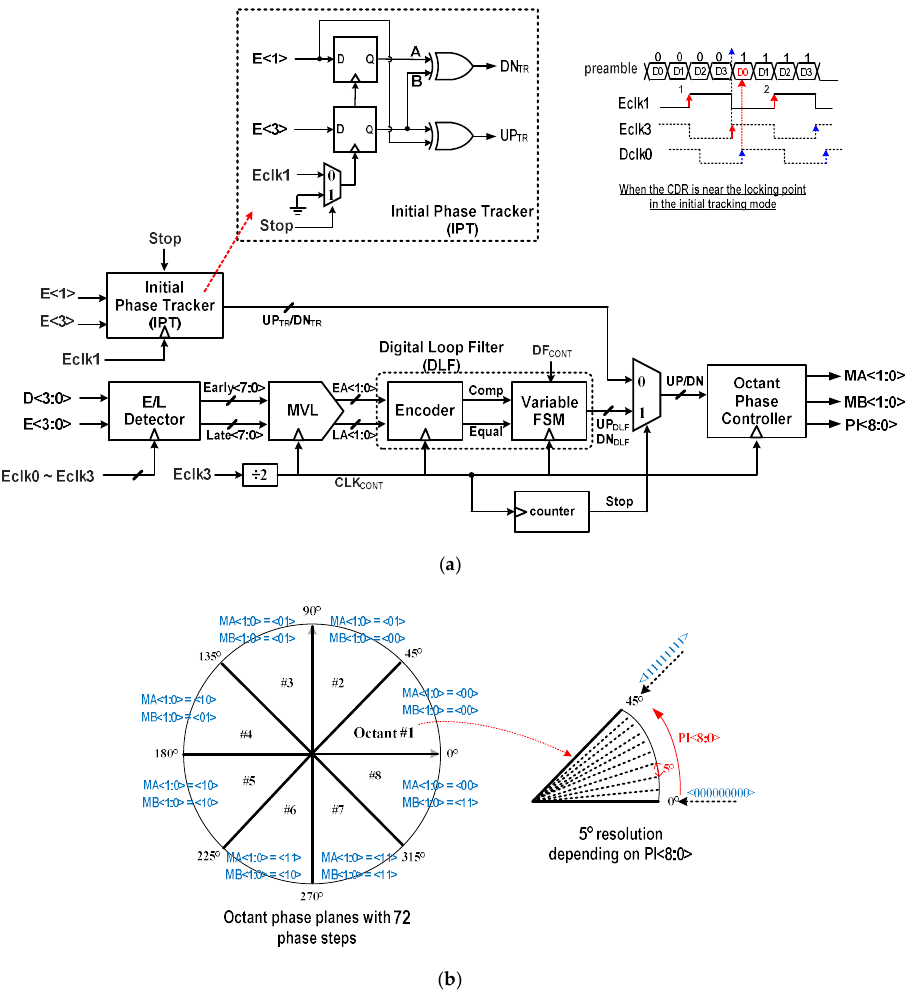
Figure 5. ( a ) Proposed PI Controller with an initial phase tracker. ( b ) Octants phase planes with